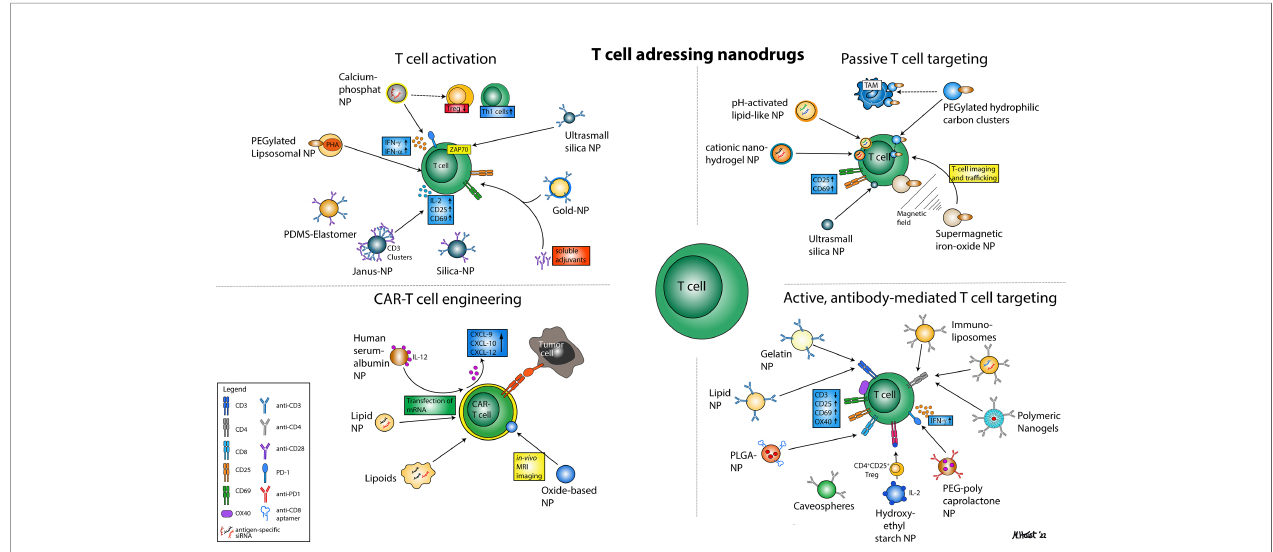
FIGURE 1 | Illustration of various nanoparticular approaches to address T cells for immunotherapy. In general, four major mechanisms can be distinguished that comprise nanodrugs aiming to activate T cells (1), nanodrugs that allow for passive (2) or active, antibody-mediated T cell targeting (3) and nanodrugs that may enhance the ef fi cacy of CAR T cell